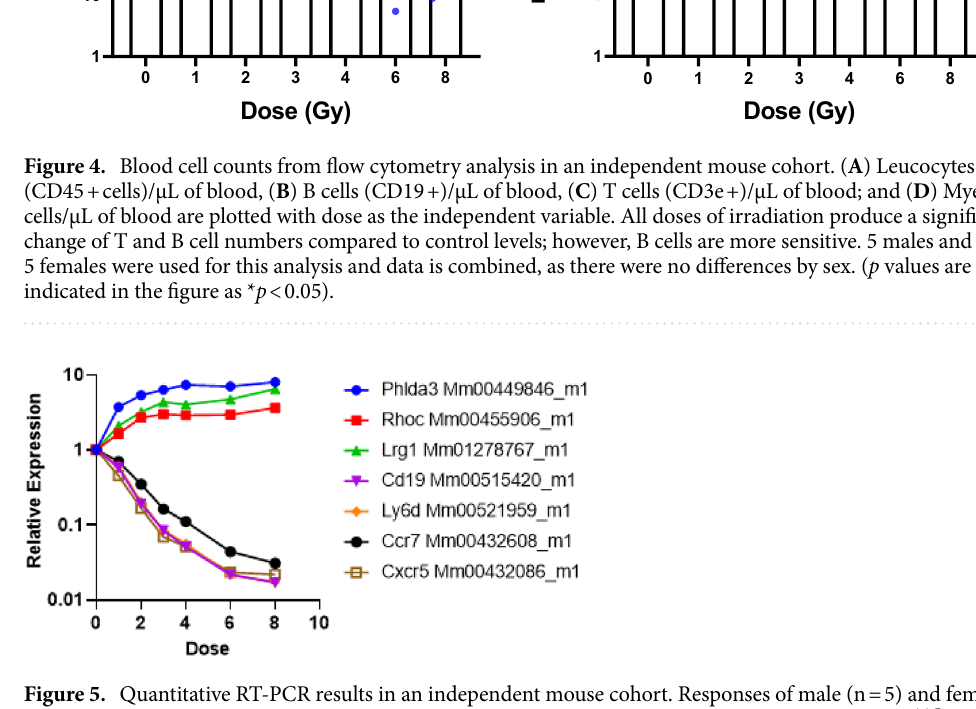
Figure 5. Quantitative RT-PCR results in an independent mouse cohort. Responses of male (n = 5) and female mice (n = 5) are plotted individually as a function of radiation dose for the 7-gene set measured by 2 −ΔΔCt method. The response of these 7 genes was the same in both sexes and is plotted separately for male and female mice in Supplementary Figure